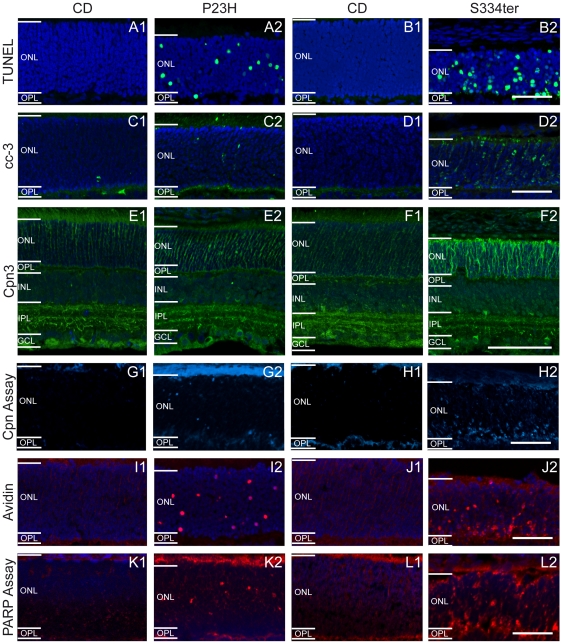
Differential regulation of cell death markers in (1) wt and (2) rhodopsin transgenic rats.(A–B) TUNEL assay for dying cells, (C–D) caspase-3 immunostaining, (E–F) calpain 3 immunostaining, (G–H) in situ calpain activity assay, (I–J) avidin binding and (K–L) in situ PARP activity assay. Left panels (A, C, E, G and I) correspond to PN15 animals and right panels (B, D, F, H and J) to PN12. All stainings showed large numbers of positive cells in P23H and especially in S334ter ONL, but not in wt retina. Scale bar = 50 µm.